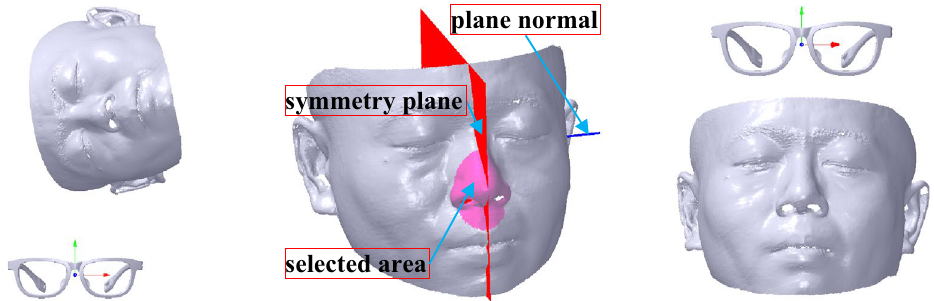
Figure 7. Face symmetry alignment. From left to right: original assembly, symmetry extraction with red plane and blue normal, symmetry alignment